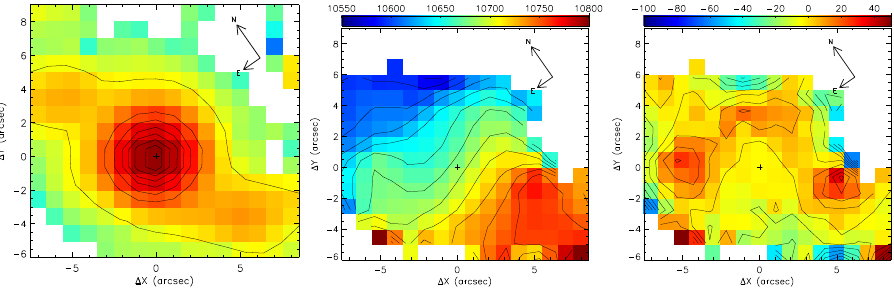
Fig. 3. MPFS data of Mrk 291 for H (cid:11) : intensity map (left), velocity (cid:12)eld (middle) and the residual velocity map (right). ‘tilted-ring’ algorithm used earlier to study NGC 6104 (Smirnova et al.